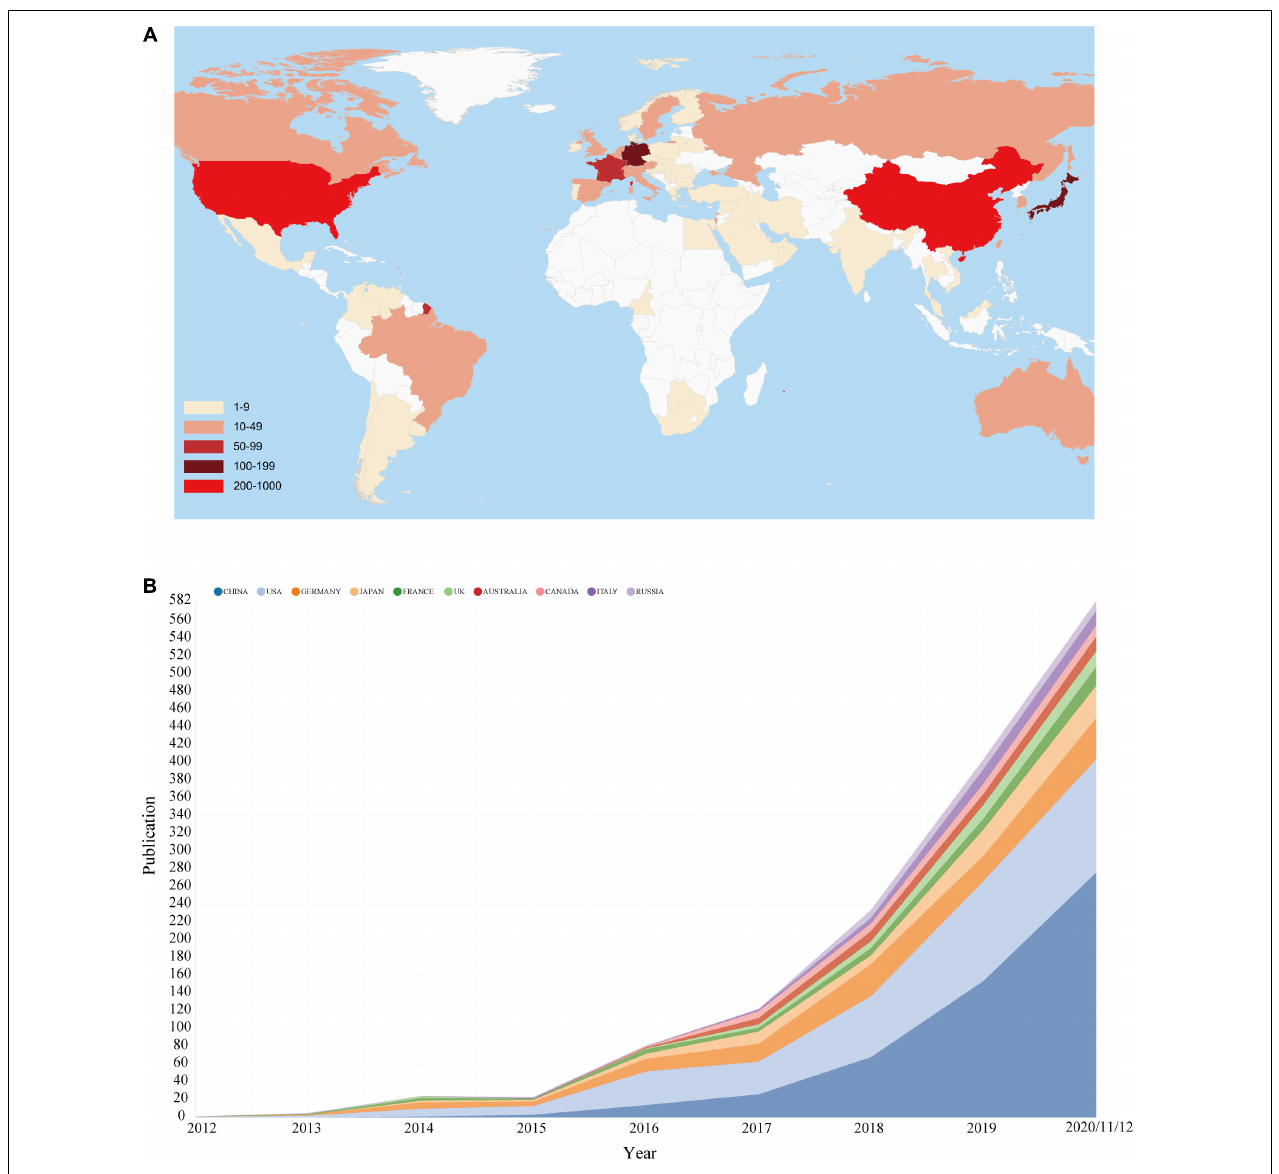
FIGURE 3 | (A) Geographical distribution map of global publications related to ferroptosis. (B) The changing trend of the annual publication counts in the top 10 countries/regions from 2012 to 2020.